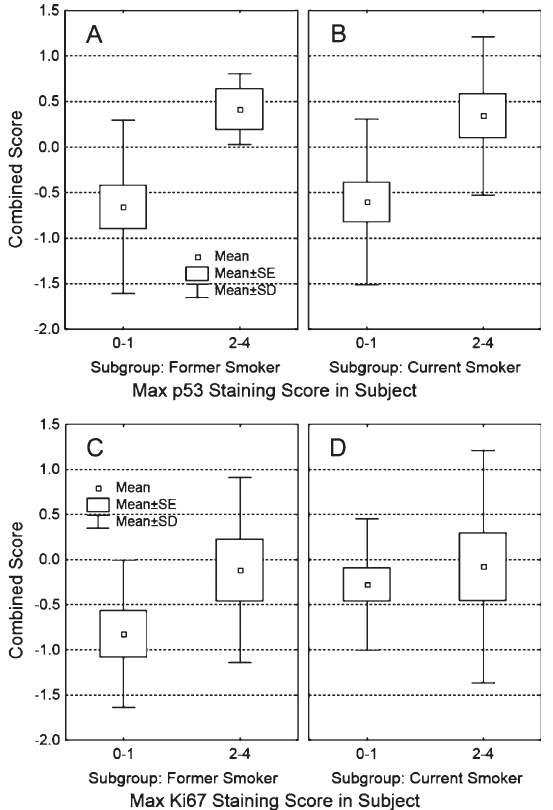
Fig. 5. Box plots comparing Combined Score to the maximum p53 (A, B) and Ki67 (C, D) staining score in that patient at that point in time. Immunostaining scores were grouped into two categories: no/weak staining (scores 0–1) and stronger staining (scores 2–4). Caseswerefurthersubdividedintoformersmoker(A,C)andcurrent smoker(B,D)groups.Forthecomparisonsshownineachofthefour panels (A–D), P =0.08, 0.008, 0.1, 0.6,